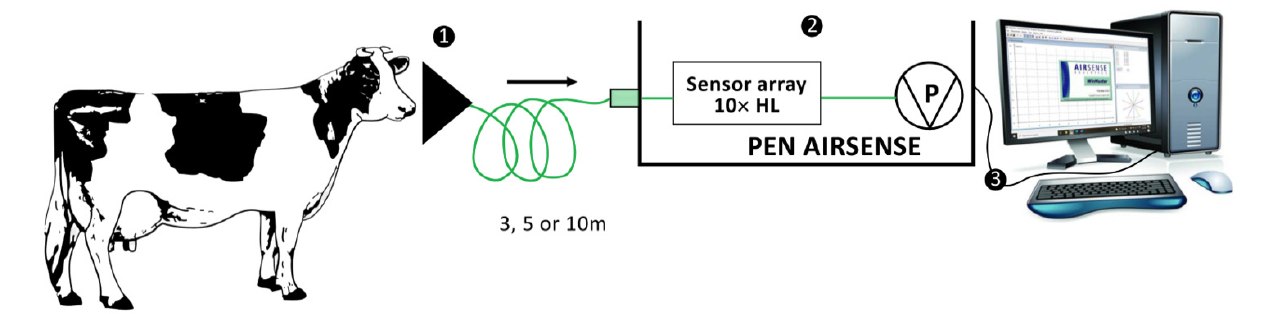
Figure 1. Schematic diagram for MENT-EGAS prototype setup for exhaled breath sample collection and its three main units: ( 1 ) collecting unit, ( 2 ) detection, analysis and identification unit, and ( 3 ) results analyzing unit.